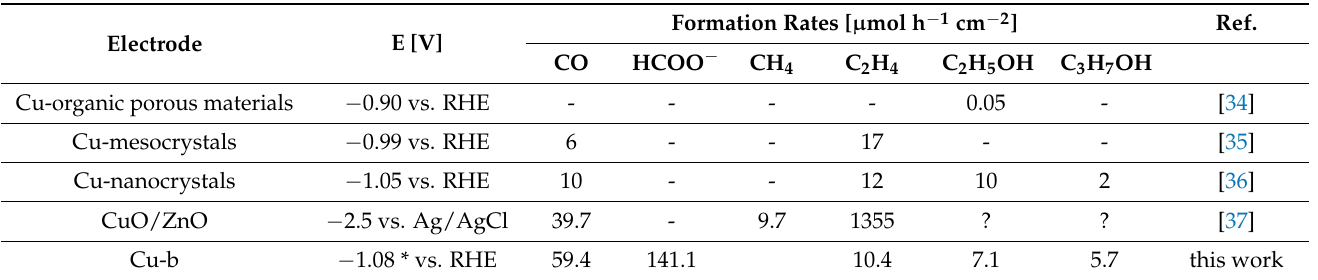
Table 5. Comparison of the product formation rates from electrochemical CO 2 reduction performed on different electrode materials. E is shown vs. RHE: * converted from − 1.7 V vs. Ag/AgCl.